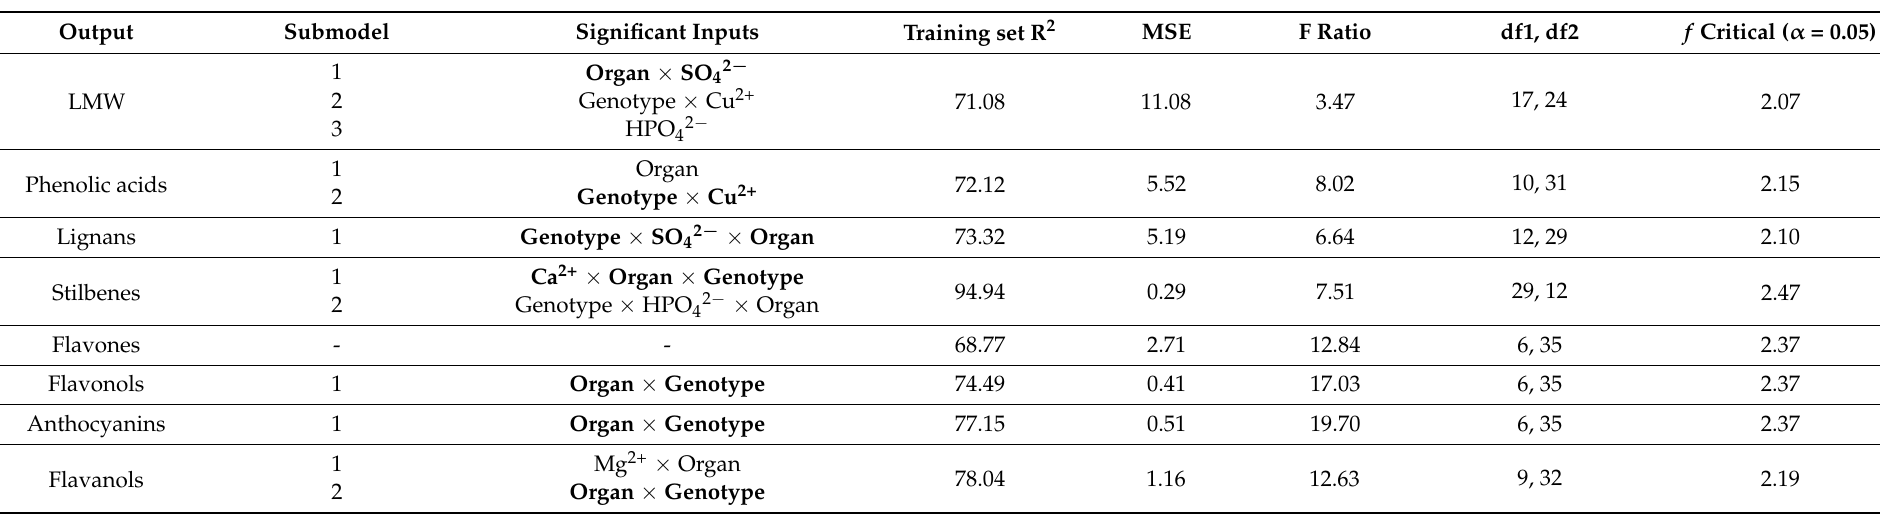
Table 1. Critical factors identified by the neurofuzzy logic model and their quality parameters for each output. Bold letters indicate the input showing the strongest effect on every output. Output